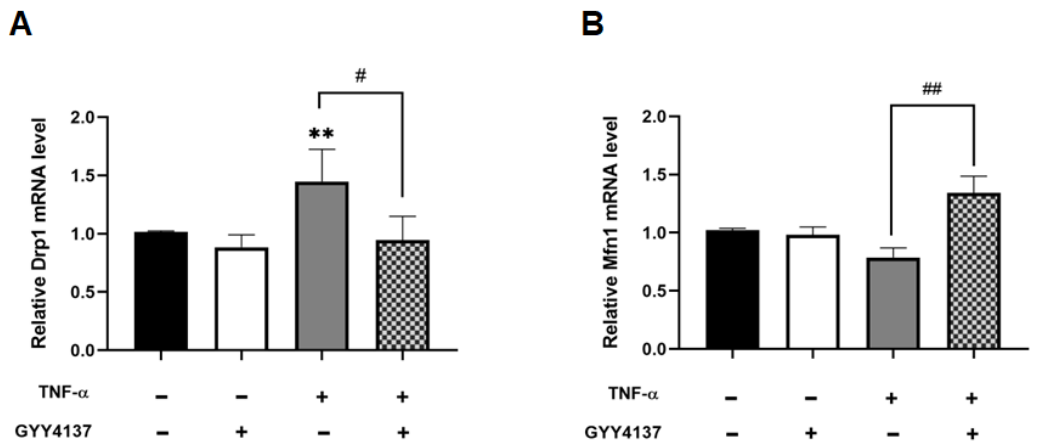
Figure 9. GYY4137 post-treatment ameliorates disruption of the mitochondrial fission/fusion ma- chinery mediated by TNF- α . ( A ) Analysis of pro-fission gene showing mRNA levels of DRPI1 N = 6 independent experiments with 3 replicates in each experiment. ( B ) RT-qPCR test of pro-fusion mRNA expression of MFN1. The extracted RNA was reverse transcribed to cDNA and calculated using the ∆∆ Ct value method with EEF2 as the housekeeping gene (n = 9). Results were shown as mean ± SD. One way ANOVA test was carried out followed by Sidak’s post hoc test to normalise for multiple comparisons comparing treatment vs. control, whereby (**) represents p < 0.01 compared to control. (# p < 0.05) and (## p < 0.01) represents a comparison to the TNF ‐α group alone.